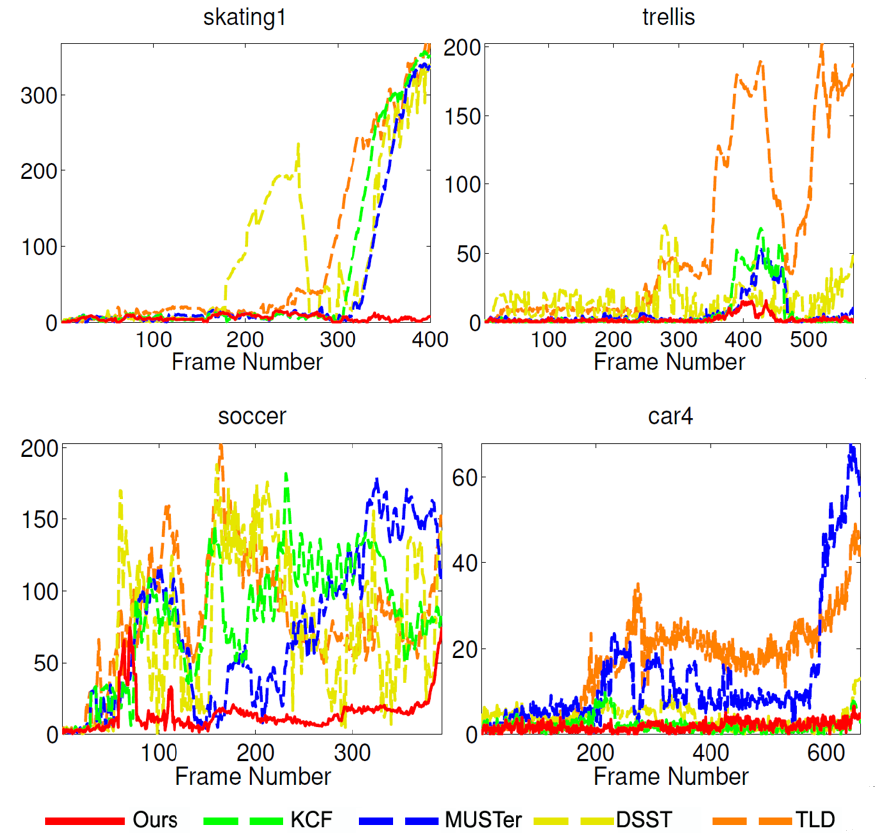
Figure 7. Fames comparison result of central location errors (in pixels) on four challenging